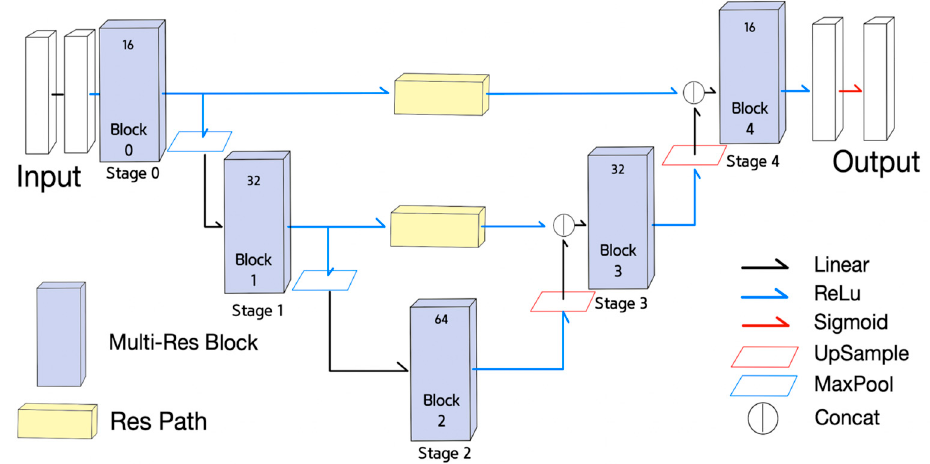
Figure 5. Half MultiResUNet.